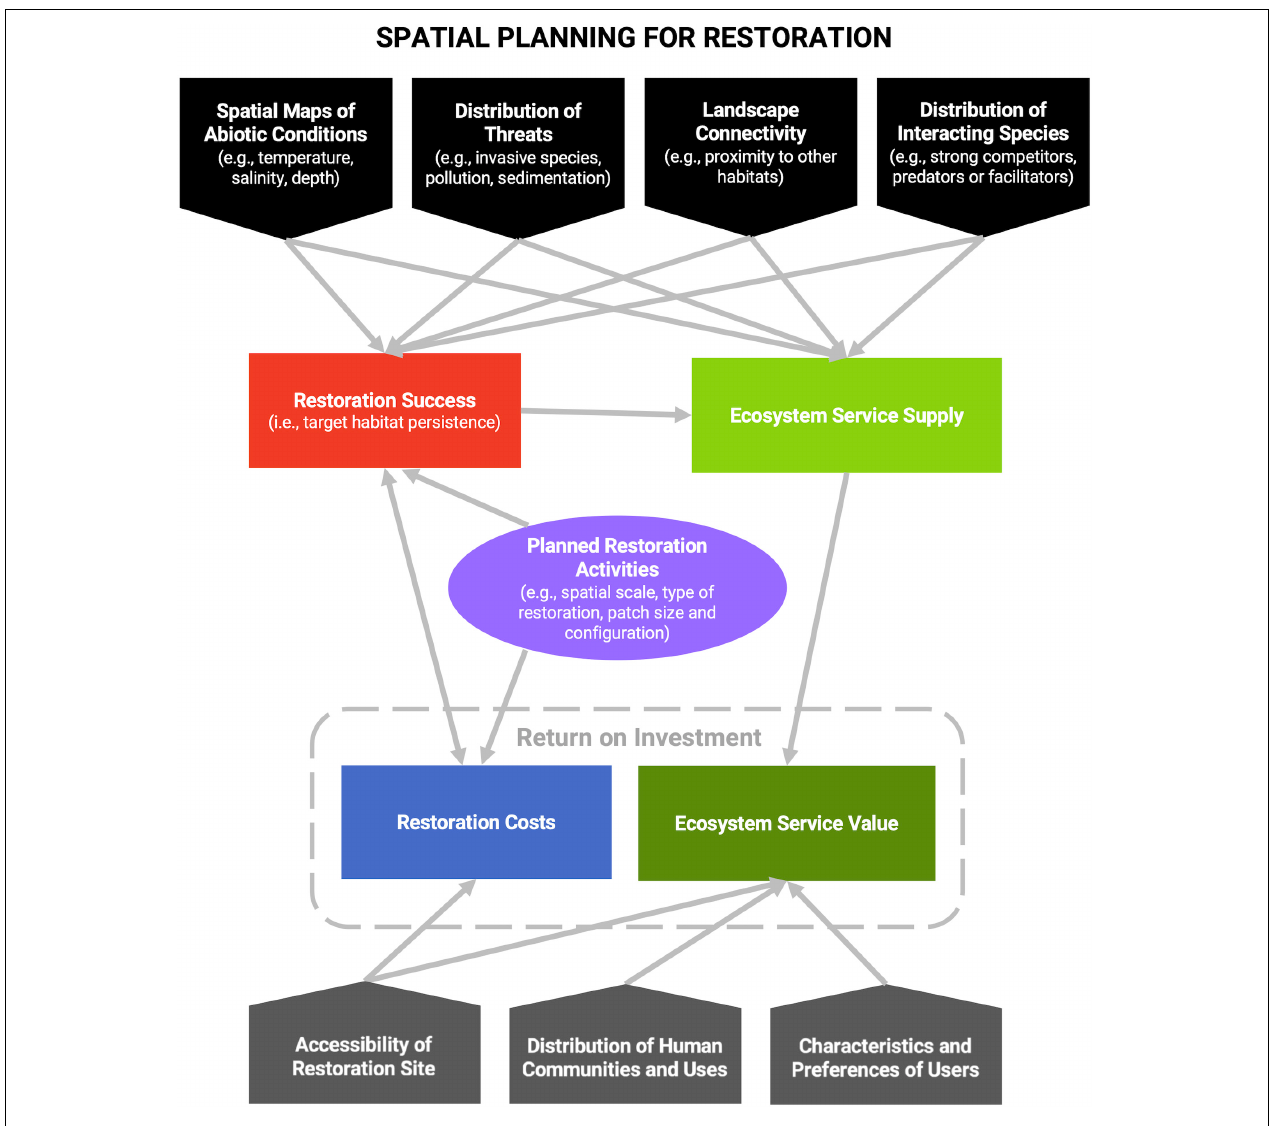
FIGURE 2 | Conceptual figure of sources of spatial variation that influence restoration success, ecosystem service supply and value, and restoration costs. Accounting for these sources of spatial variation in restoration planning and site selection has the potential to improve return on investment, which we use here broadly to refer to the ecological and ecosystem service benefits (i.e., return) and the financial and social costs (i.e., investment) of